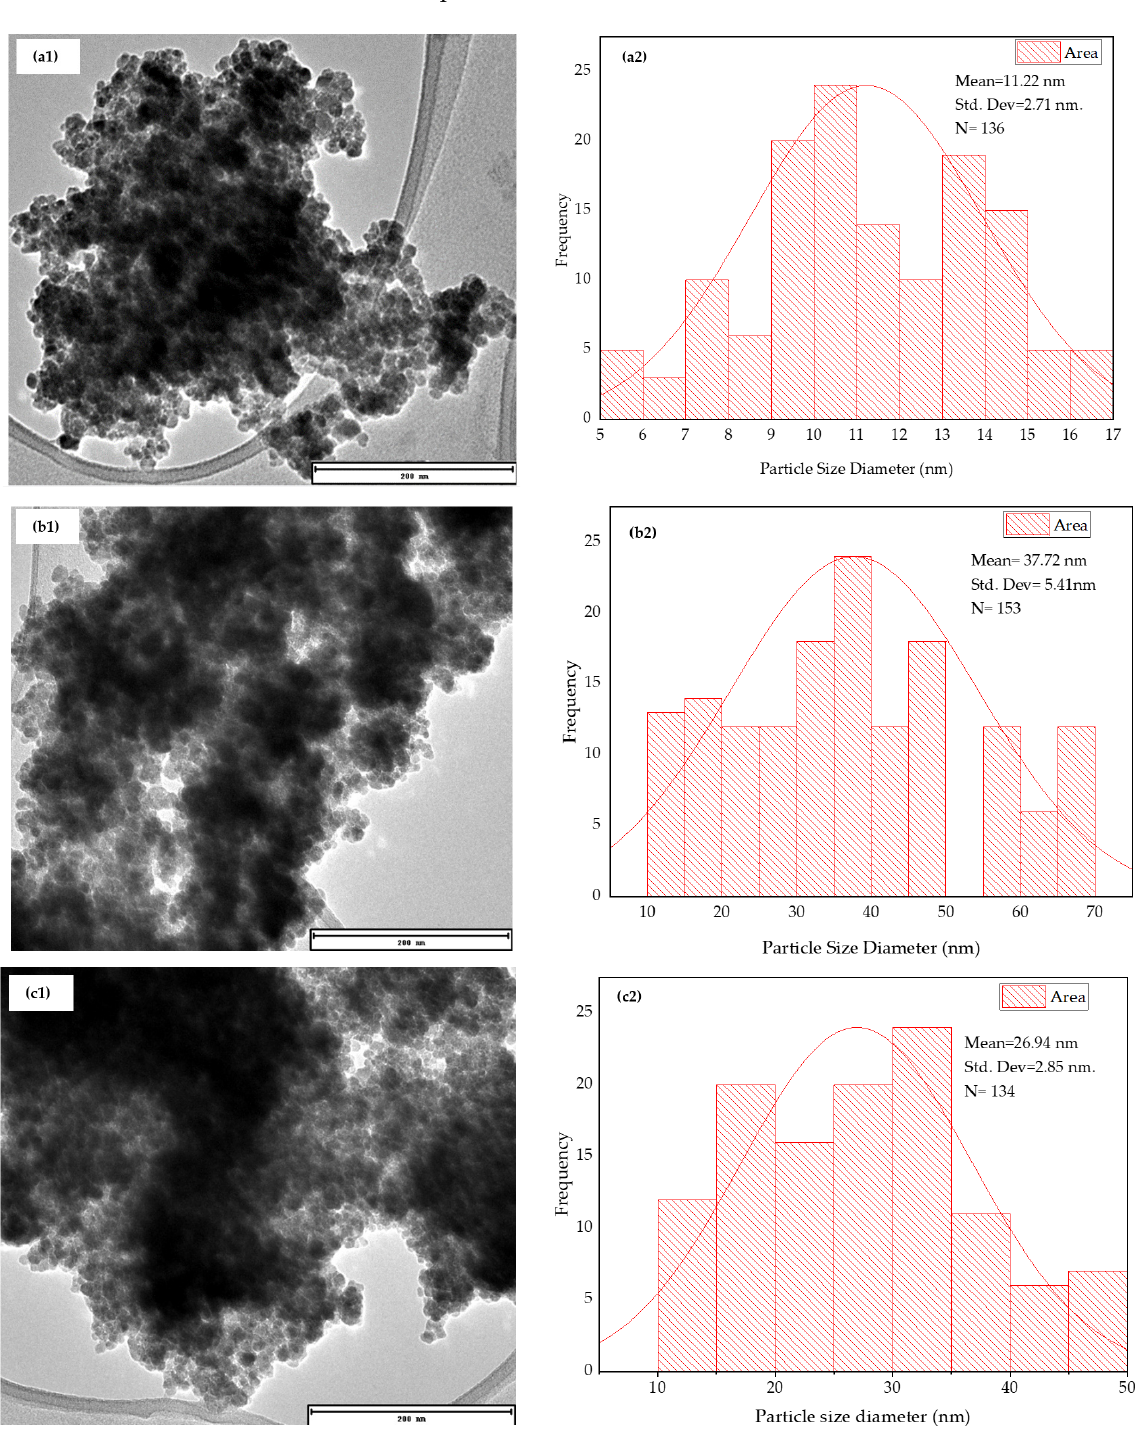
Figure 7. TEM micrographs and histogram for MNPs ( a1 , a2 ), CPC-MNPs ( b1 , b2 ), and CNC-MNPs ( c1 , c2 ).